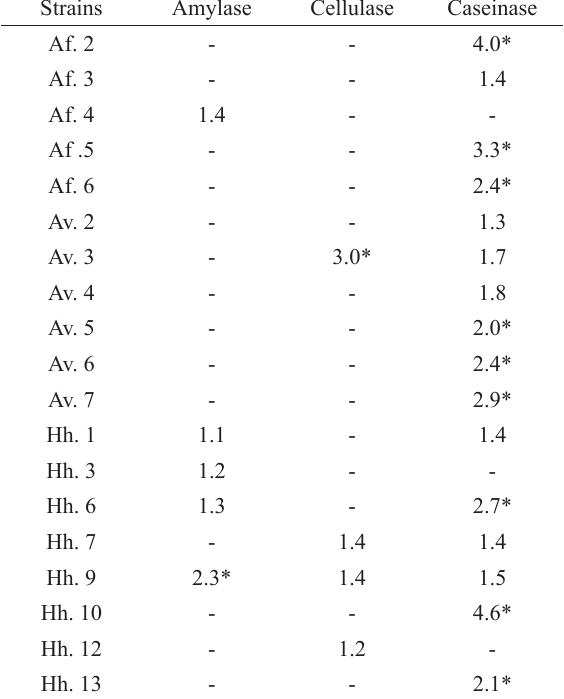
Values of Enzymatic Index (EI) for strains isolated from sponges for the different substrates